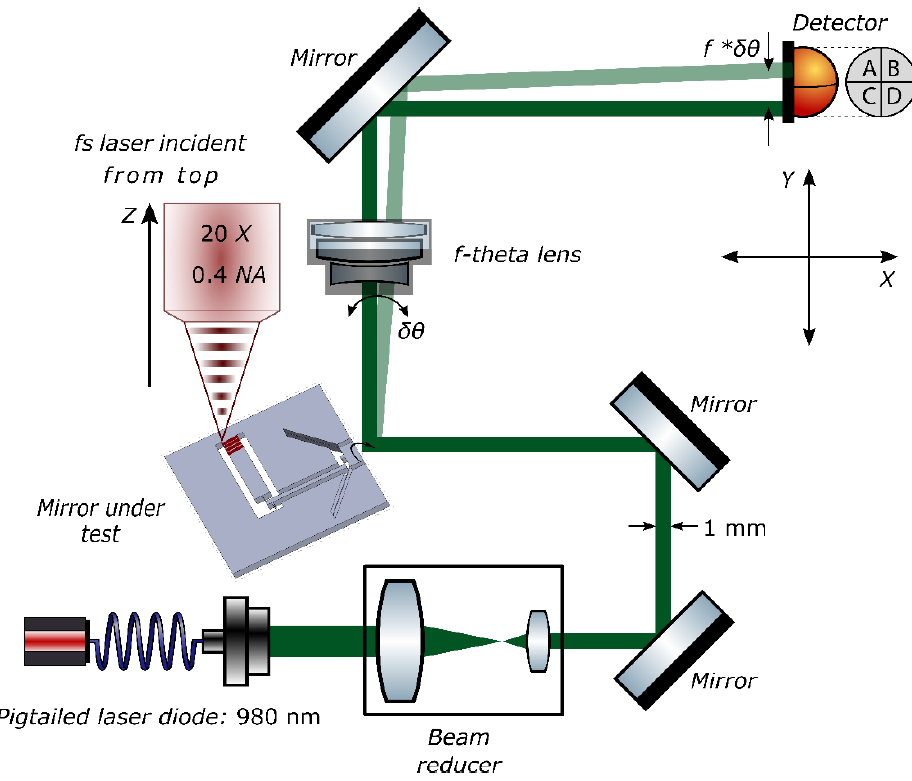
Figure 4. A schematic of the experimental test bench. A probe laser beam is focused, re-collimated and reflected off the test mirror. The reflected beam is then focused by an f-theta lens on a position sensing detector (PSD) that records its position in real-time. The whole assembly is then moved under the focus of a femtosecond laser and a sequential pattern of laser affected zones is written inside the actuator. The modifications induce a net strain causing the mirror to rotate about its center. The subsequent change in the position of the focal spot is then recorded and monitored on the detector.